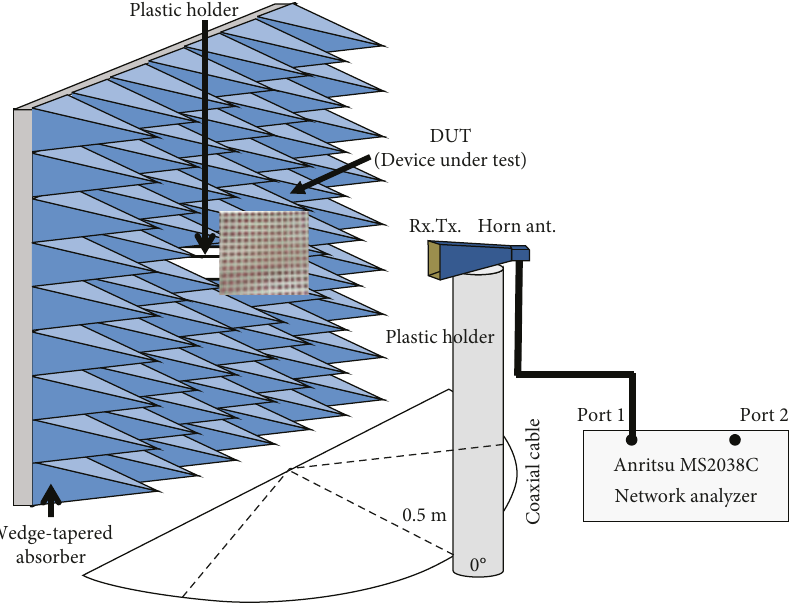
Figure 4: Illustration of the free space absorption ratio measurement setup under normal